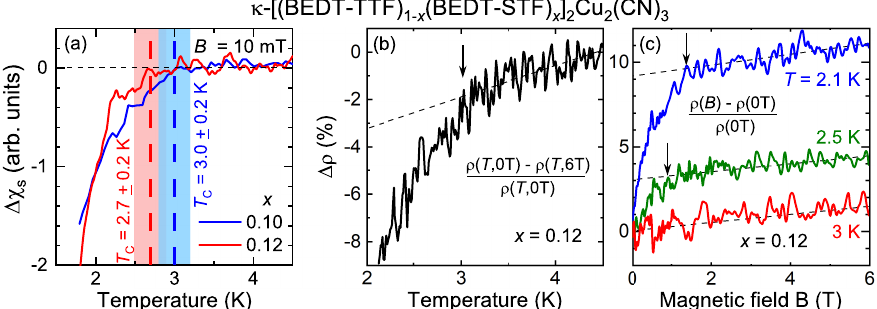
Figure 4. ( a ) Temperature-dependent magnetic susceptibility of polycrystalline κ -[(BEDT-TTF) 1 − x - (BEDT-STF) x ] 2 Cu 2 (CN) 3 for the substitution values x = 0.10 and 0.12 measured by a SQUID in an external field of 10 mT. The superconducting transition T c = 2.7 K and 3.0 K can be determined from the temperature where χ S ( T ) starts to drop. The data were taken in zero-field-cooled mode upon warming up. ( b ) Normalized DC resistivity of κ -[(BEDT-TTF) 0.88 (BEDT-STF) 0.12 ] 2 Cu 2 (CN) 3 comparing a zero magnetic field with B = 6 T. The strong deviation below 3 K indicates the suppression of superconductivity. ( c ) The magnetoresistance ∆ ρ corresponds to the relative change in resistivity due to an external magnetic field B . While for higher temperatures ( T = 3 K), there is linear increase of ∆ ρ ( B ) with B , a kink is observed at lower temperatures, indicated by the black arrows. This corresponds to the suppression of the superconductivity, i.e., the upper critical field.